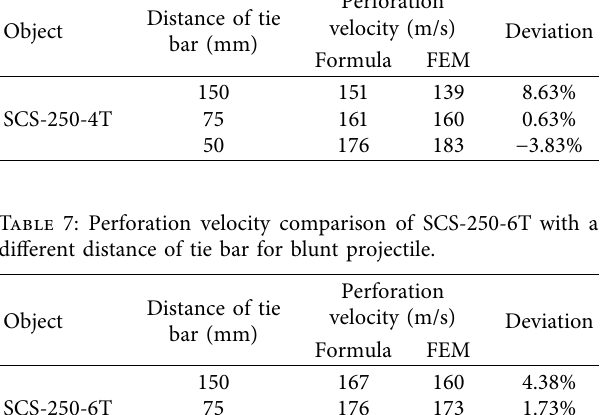
Table 6: Perforation velocity comparison of SCS-250-4T with a different distance of tie bar for blunt projectile. Object